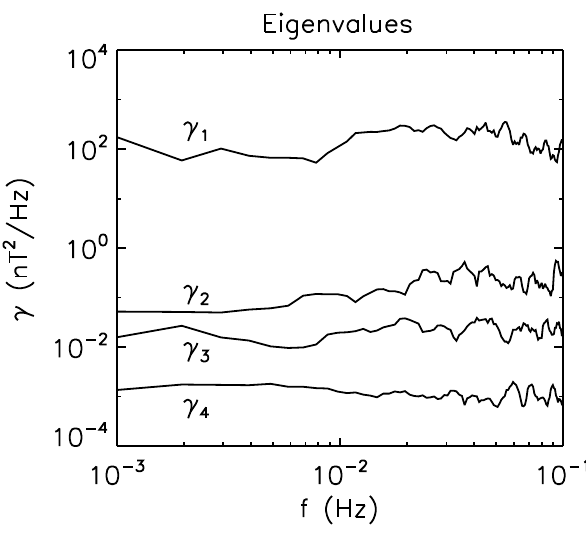
Fig. 5. Eigenvalues of the CSD matrix for the analysis example presented in Sect. 5. The first eigenvalue is clearly much larger than the other eigenvalues throughout the whole frequency range which confirms that we are dealing with a single dominant mode in this